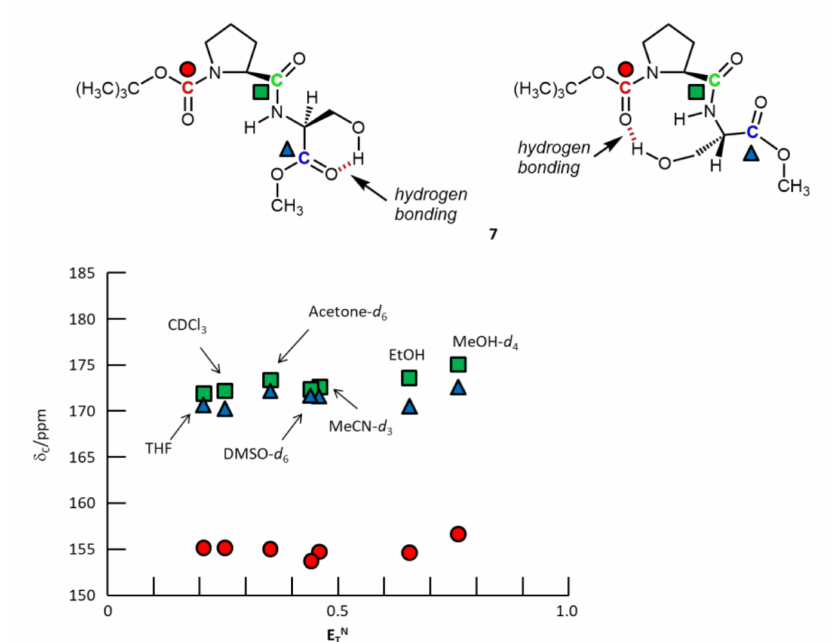
Figure 10. 13 C NMR chemical shifts of the carbonyl carbons of N -Boc-L-proline-L-serine-OMe 7 .